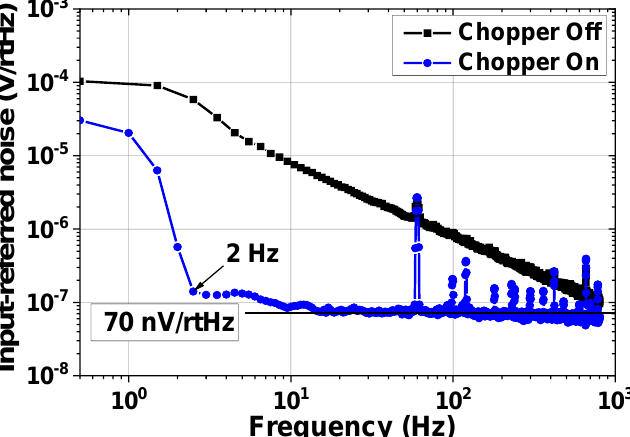
Figure 22. Measured input-referred noise voltage spectral density of the ECG channel.